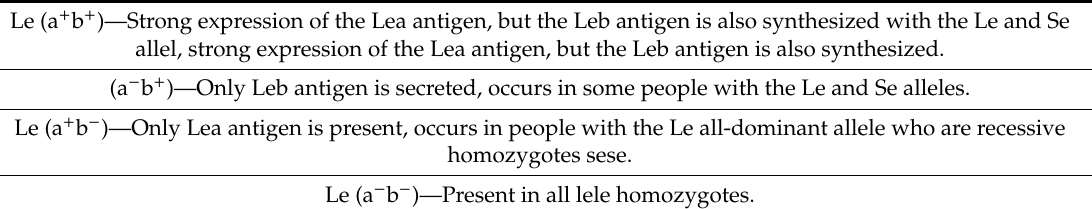
Table 3. Phenotypes based on the Lewis